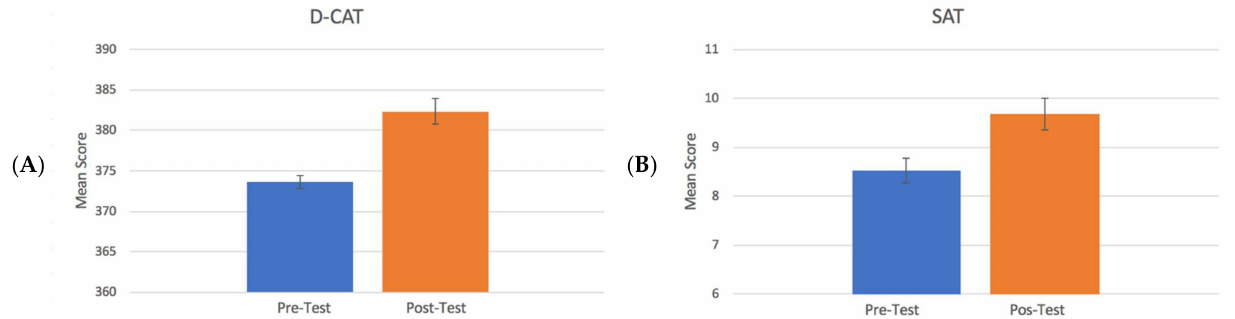
Figure 5. Results of attention span assessment tests before and after training (with 95% CI for the mean). ( A ) D-CAT assessment test results. ( B ) SAT assessment test results.